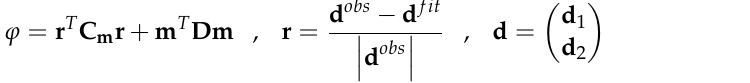
Figure 4. An example of TEM survey using the fixed-loop